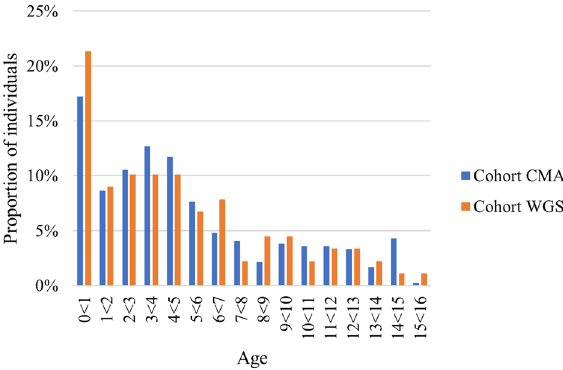
Figure 1. Age distribution upon